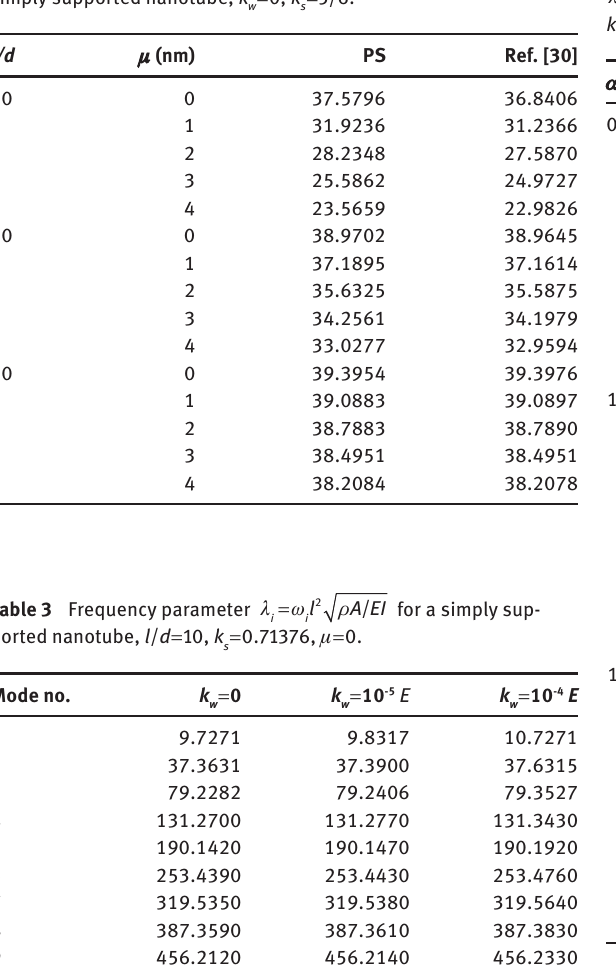
Table 4 Influence of nanoparticle inertia on frequency parameter